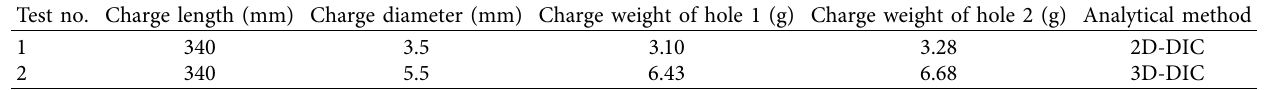
Figure 1: Introduction of blasting experiments: (a) details of the specimens; (b) borehole stemming method; (c) specimen restraint. Table 2: Parameters of